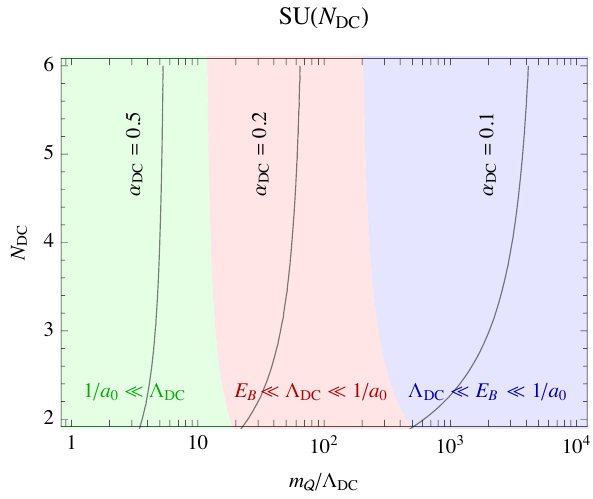
Figure 2 . Qualitatively di(cid:11)erent regions described in the text as function of the mass hierarchy m = (cid:3) DC and of N DC , superimposed to a contour plot of (cid:11) Q SU( N DC ) gauge group; similar results hold for SO( N DC